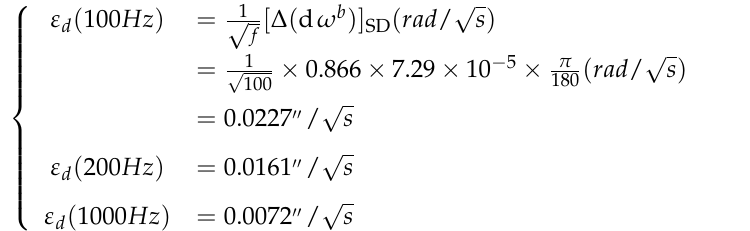
Figure 5. Heading error incremented by seconds in simulation test.